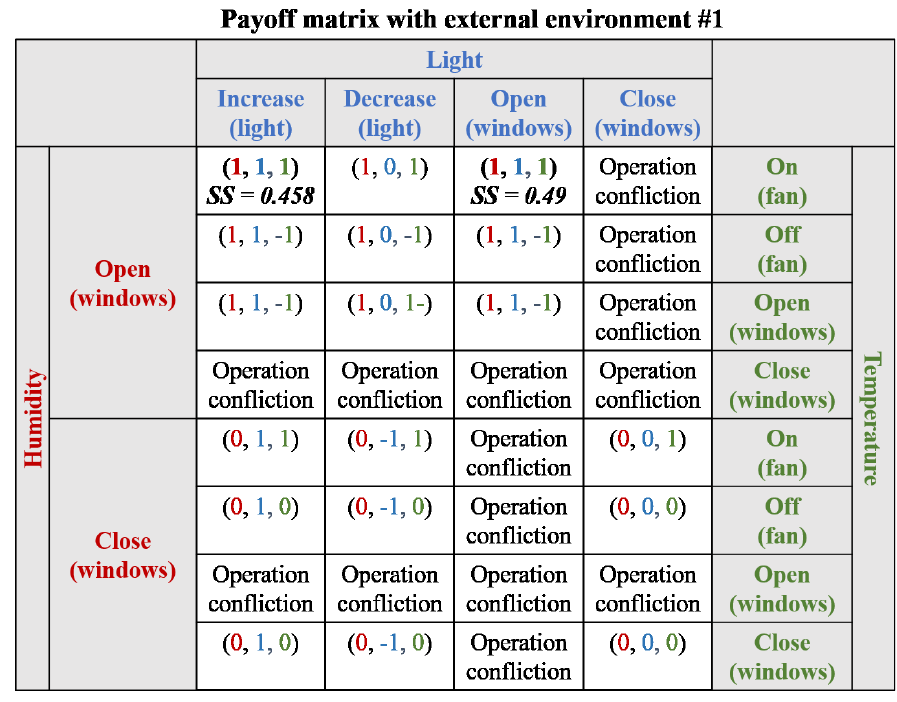
Figure 10. Payoff matrix for Scenario #3 with external environment #1 ( α = 0.5 and β =